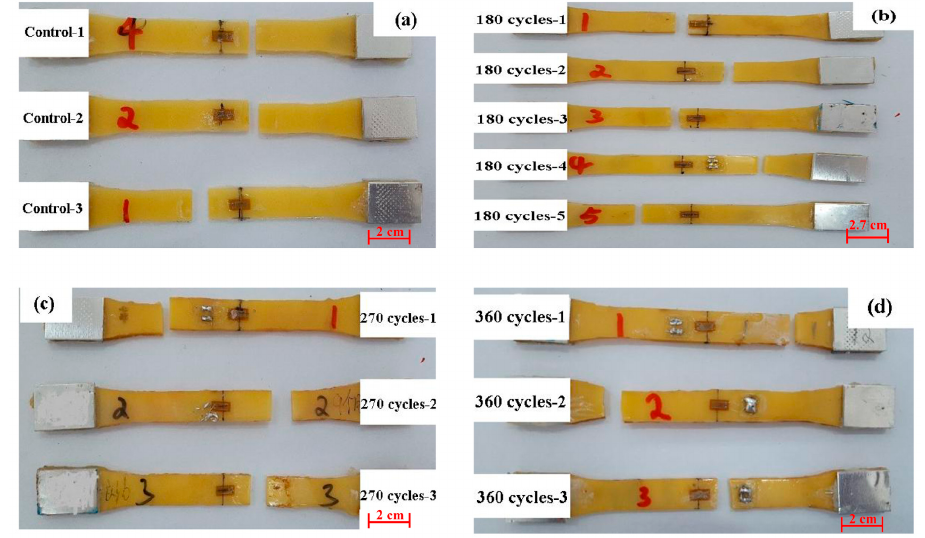
Figure 7. Failure modes of the epoxy resin matrix, ( a ) control; ( b ) 180 cycle times; ( c ) 270 cycle times; ( d ) 360 cycle times. ( d ) 360 cycle